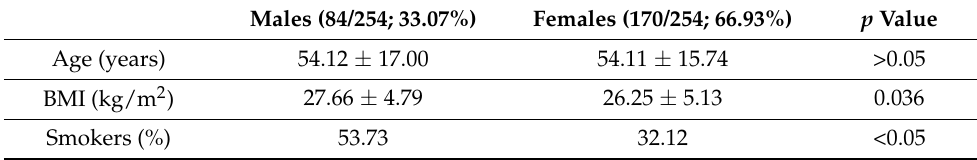
Figure 1. Flow-chart demonstrating study design. Table 1. Characteristics of the participants of the study.